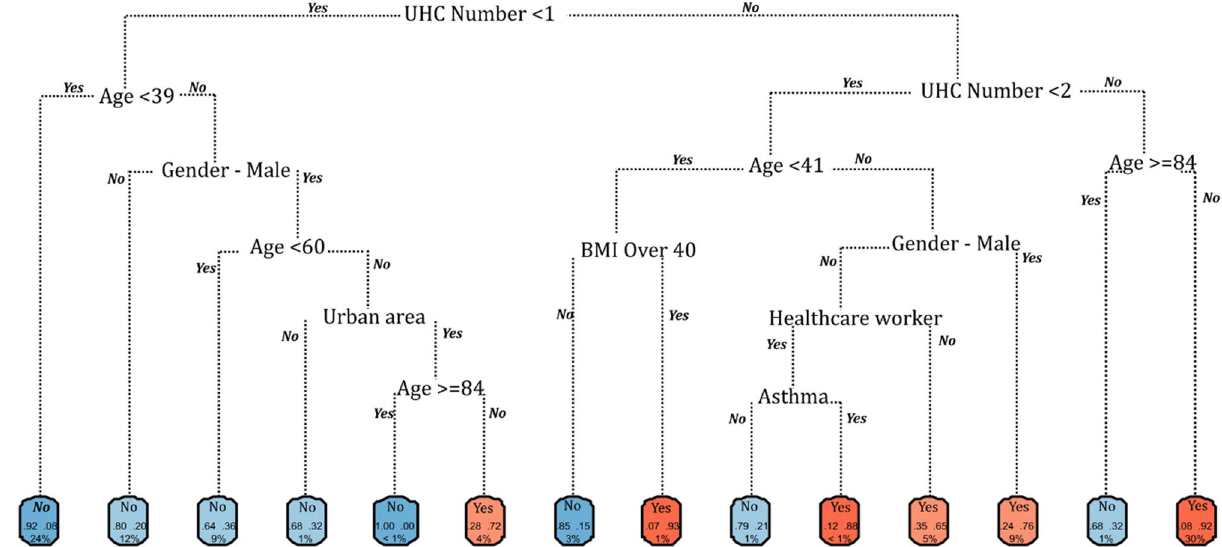
Figure 4. Recursive partitioning and regression tree (rtree) model for ICU admission among symptomatic COVID-19 cases in the Republic of Ireland, February to November 2020.